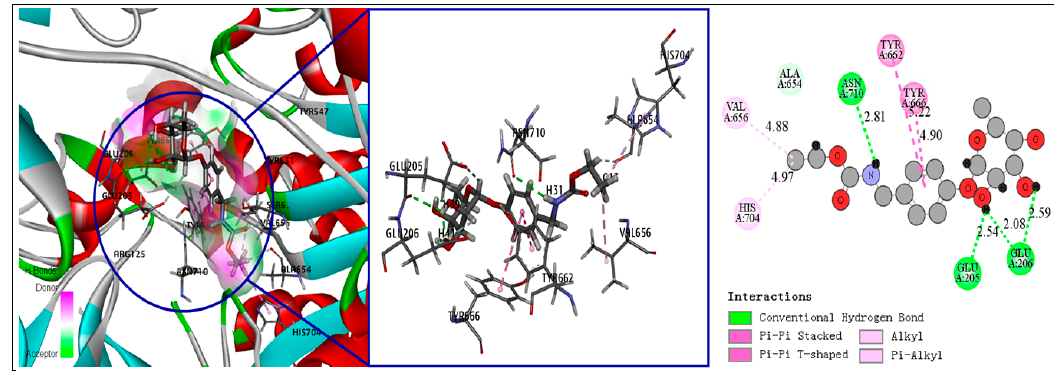
Figure 3. Receptor–ligand interaction of compound 1 with dipeptidyl peptidase (DPP-IV) binding site.